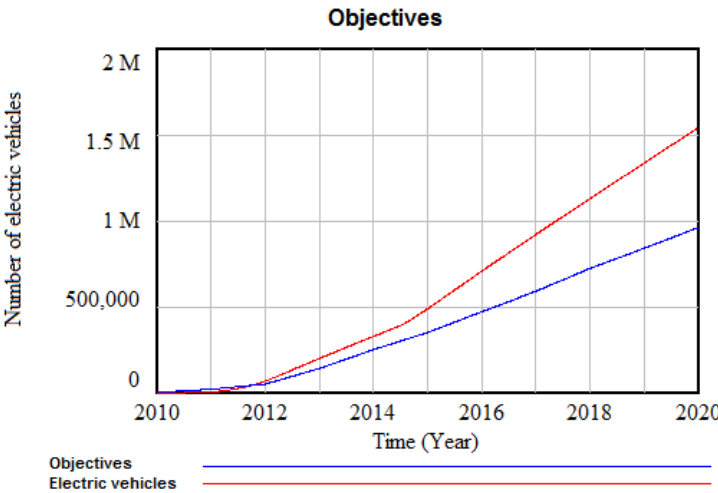
Figure 15. Electric vehicle fleet compared to the Government target for the optimistic scenario with subsidies until 2020 (the authors’ calculations).